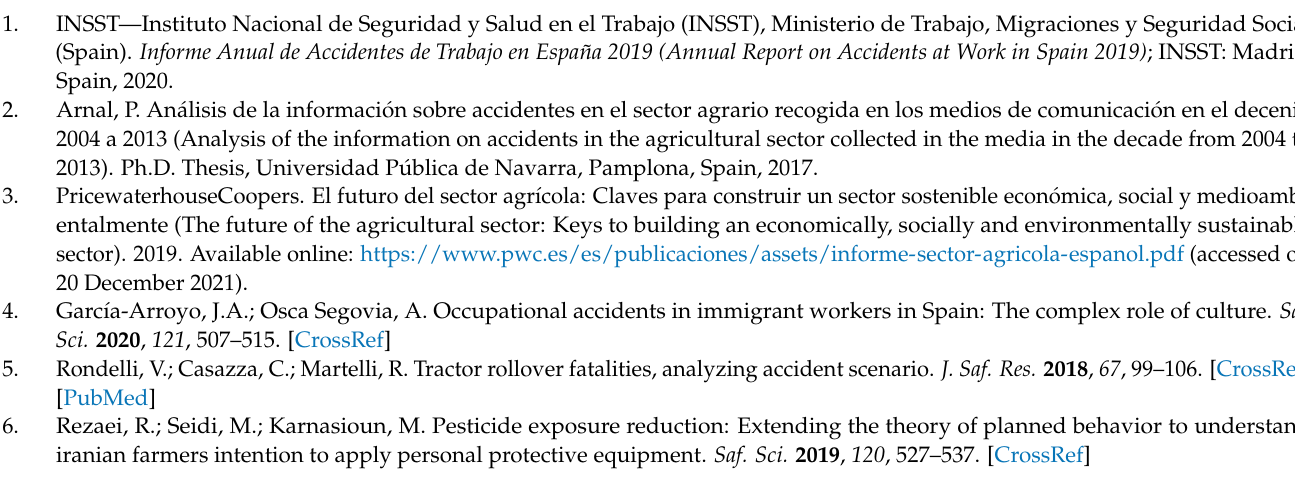
autonomous communities. Figure S2: map of Spain divided into its provinces. Figure S3: map of slopes (%) of